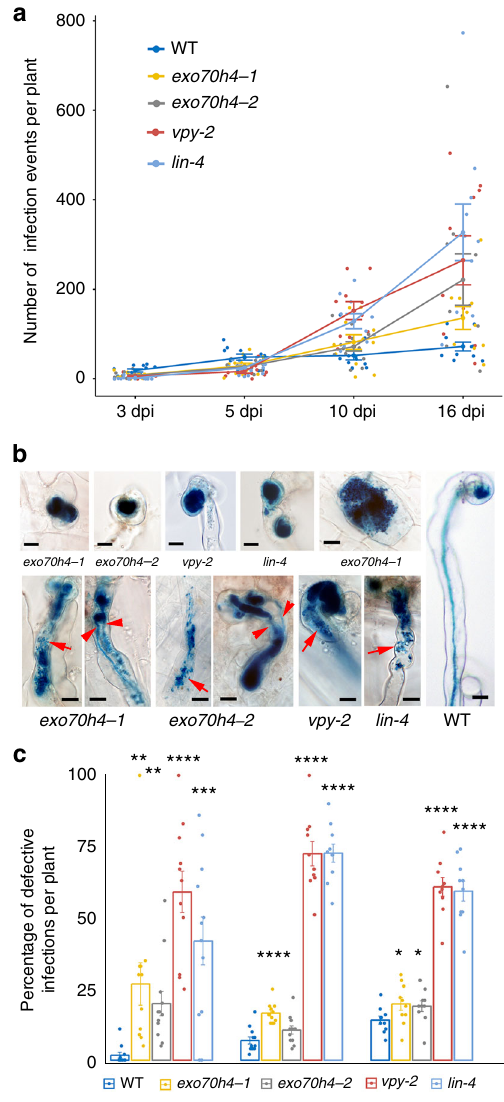
Fig. 10 Rhizobial infection phenotypes of exo70h4, vpy and lin . a Rhizobial infection time course of WT, exo70h4-1 , exo70h4-2 , vpy-2 and lin-4 . All infection events from microcolony to rami fi ed cortical infection threads were counted from 9 to 12 plants for each genotype at 3, 5, 10 and 16 dpi with Rm1021-lacZ respectively. Bars represent standard error. b Typical defective infection events of exo70h4-1 , exo70h4-2 , vpy-2 and lin-4 (left) and a normal elongating infection event of WT (right). Top left, abnormal infection in the epidermal cells ( exo70h4-1 ). Bottom left, blocked infection threads, branched infection threads (arrowheads) and disintegrated infection threads resulting in rhizobia release (arrows) in the mutant root hairs of exo70h4-1 , exo70h4-2 , vpy-2 and lin-4 . Scale bars, 10 µ m. c Quanti fi cation of defective infection events in WT, exo70h4-1 , exo70h4-2 , vpy-2 and lin-4 at 5, 10, 16 dpi, respectively. All genotypes are in R108 background. Bars show the percentage of defective versus all infection events per plant. Error bars represent standard error. Two-tailed Student ’ s t -test, * p < 0.05; ** p < 0.01; *** p < 0.001; **** p < 0.0001. Source data are provided as a Source Data fi